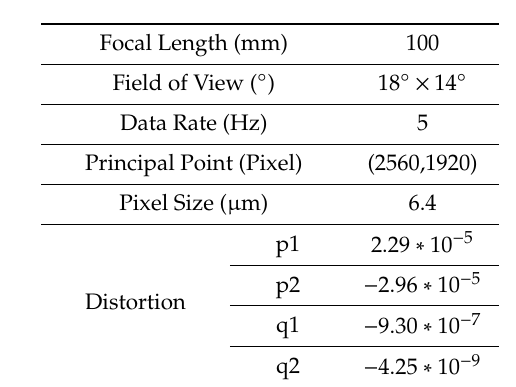
Table 2. Star Camera